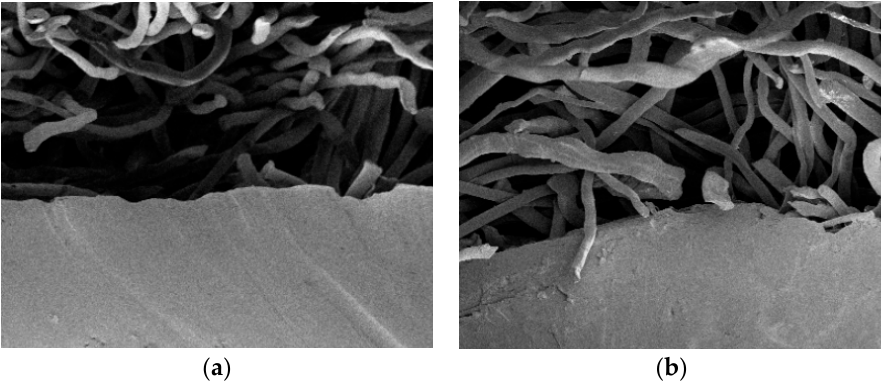
Figure 8. Microscopic observation results (100×): ( a ) 850 days submersion, acidic; ( b ) 850 days submersion, basic.